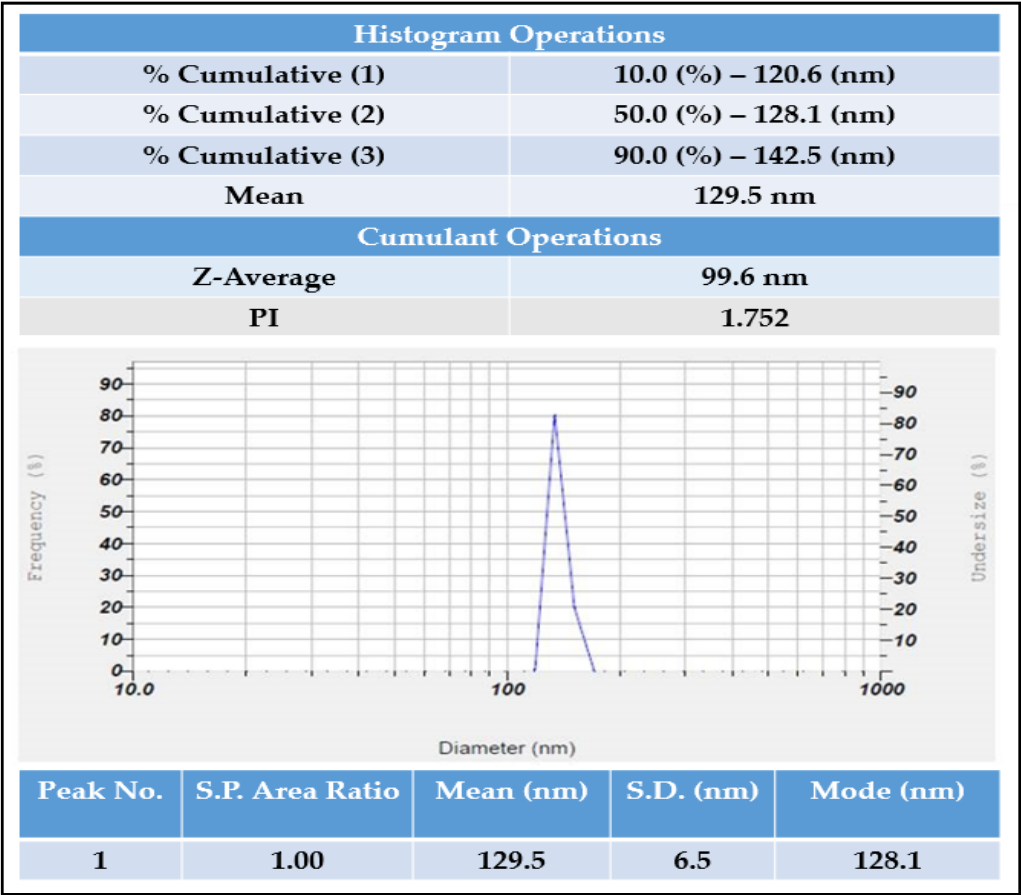
Figure 8. Particle size analysis of R. apiculata AgNPs.